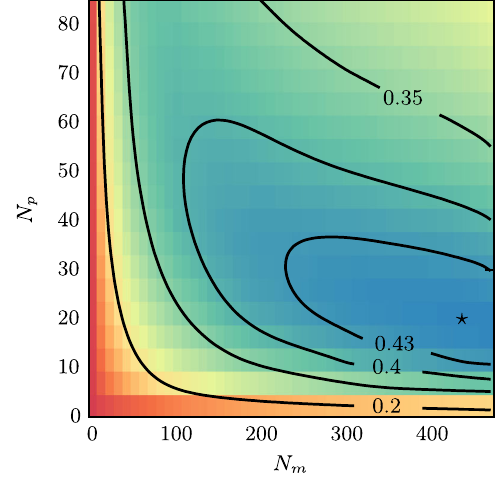
FIG. 3. The difference in probability, Δ P (cid:2) ¼ P (cid:2) ð T; _ γ Þ − ρ a function of N and N for a temperature of T ¼ 0 . 1 and strain m p rate _ γ ¼ 10 − 4 . We see a broad plateau over which Δ P (cid:2) is largely independent of N and N with a weak maximum occurring at m p ¼ 430 and N ⋆ ¼ 20 (marked by a star.) The behavior of Δ P (cid:2) N ⋆ m p is largely independent of temperature and strain rate.